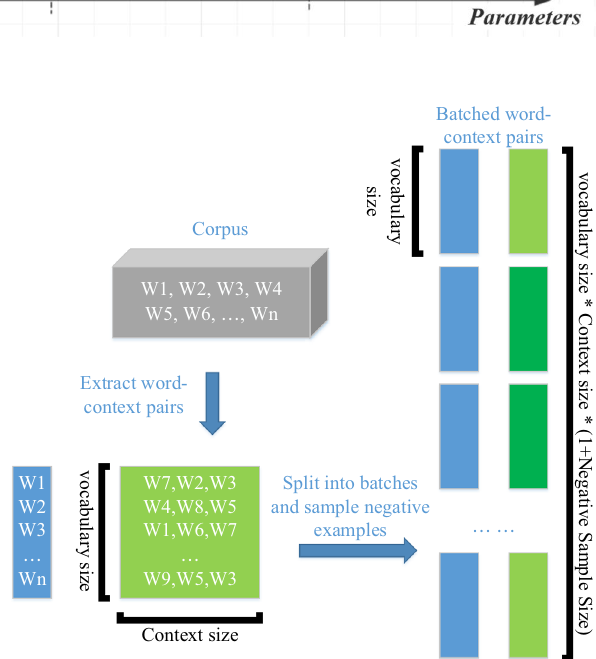
Fig. 5 Illustration of flat and sharp minimum [25]. The Y -axis indicates value of the loss function. The X -axis indi- cates parameters (reduced to 1 dimension). In sharp minimum, the value of loss function changes rapidly with parameters in a relatively small range. Suppose a set of parameters achieves the lowest loss in train- ing function, the loss on testing function for flat minimum is much lower than that for sharp minimum